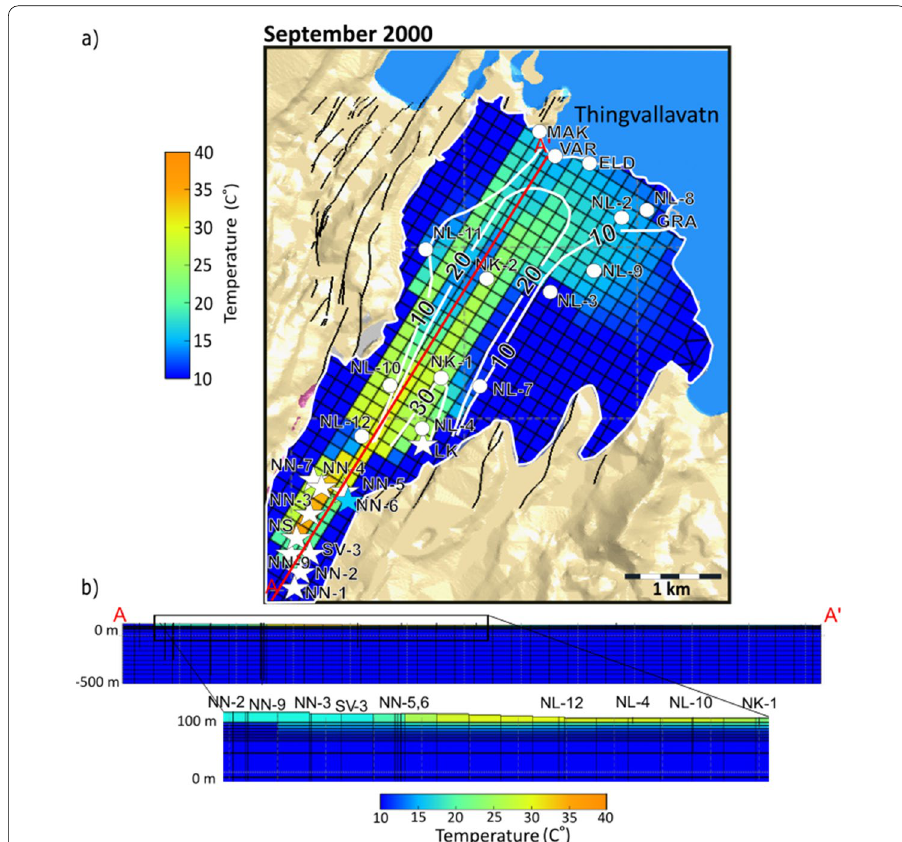
Fig. 12 a Comparison between measured temperature at one meter below the groundwater table for September 2000. The contour lines represent the temperature registered from ÍSOR data. White dots are the monitoring station, white stars are the injection wells and blue star is the injection well NN‑6 chosen for the tracer test. b Cross section along the most permeable fault